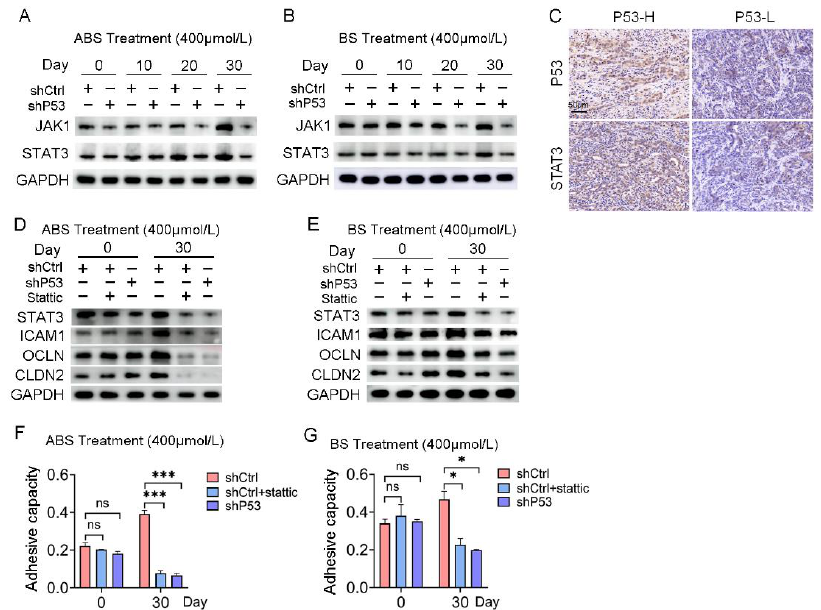
Figure 5. The JAK/STAT signaling pathway is involved in P53 dependence on bile acid-induced cell adhesion. ( A ) The expression levels of JAK1 and STAT3 after ABS treatment. ( B ) The expression levels of JAK1 and STAT3 after BS treatment. ( C ) Representative images of P53 and STAT3 IHC staining. ( D ) Expression of cell adhesion markers ICAM1 , OCLN , CLDN2 and STAT3 in HET1A cells with P53 knockdown or Stattic treatment after ABS stimulation for 30 days. ( E ) Expression of cell adhesion markers ICAM1 , OCLN , CLDN2 and STAT3 in HET1A cells with P53 knockout or Stattic treatment after BS stimulation for 30 days. ( F ) Cell adhesion capacity after exposure to ABS for 30 days after STAT3 inhibitor Stattic treatment. ( G ) Cell adhesion capacity after exposure to BS for 30 days